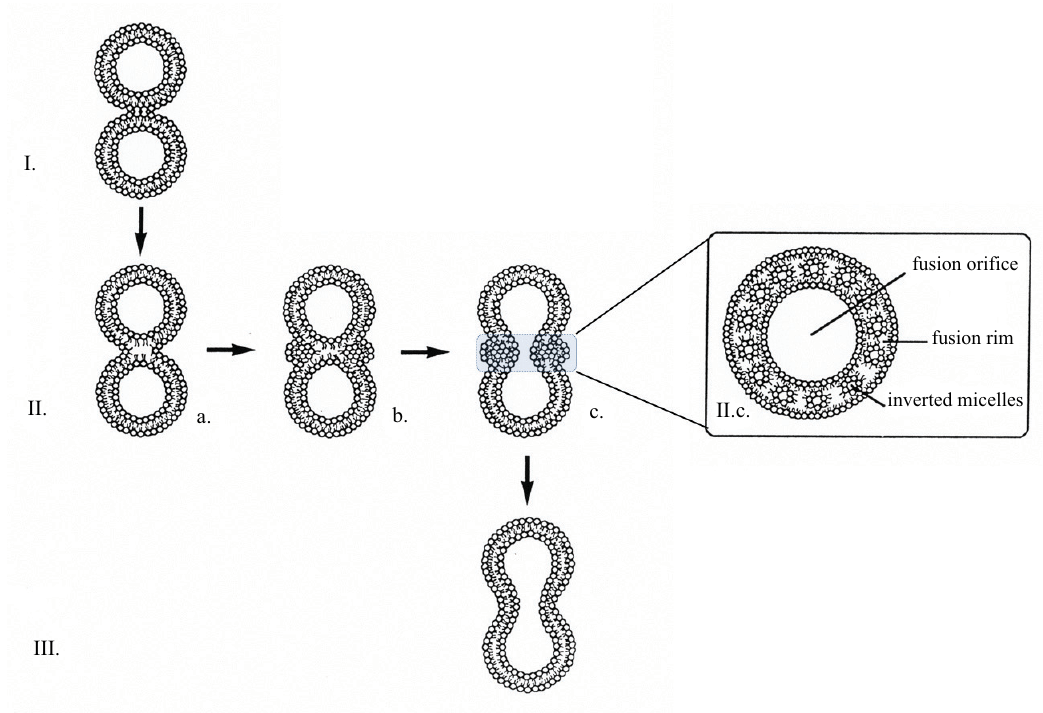
Figure 2. Possible fusion mechanism in a model liposome dispersion induced by glycerin. I. Close apposition of two bilayers and formation of an aggregation site when bilayers touch each other. II. Merging of two bilayers. a ) formation of the initial fusion product: the outer leaflets of the bilayers of both vesicles join (fuse), while their inner bilayer leaflets form one common bilayer at the attachment site. b ) phospholipid molecules from the outer leaflet of the vesicle bilayers, ie. From the attachment site are pushed sideways and form inverted micelles; at the attachment site transient bilayer form composed of the inner bilayer leaflets of the vesicles. c ) formation of the fusion orifice: the phospholipid molecules from the attachment site are used for the formation of the outer monolayer of the inverted micelles. Inverted micelles are situated all around the fusion orifice. Mixing of the contents of the vesicles has started. Boxed insert shows a horizontal section of the fusion area viewed from above. III. Expansion of the bilayer to form a single larger